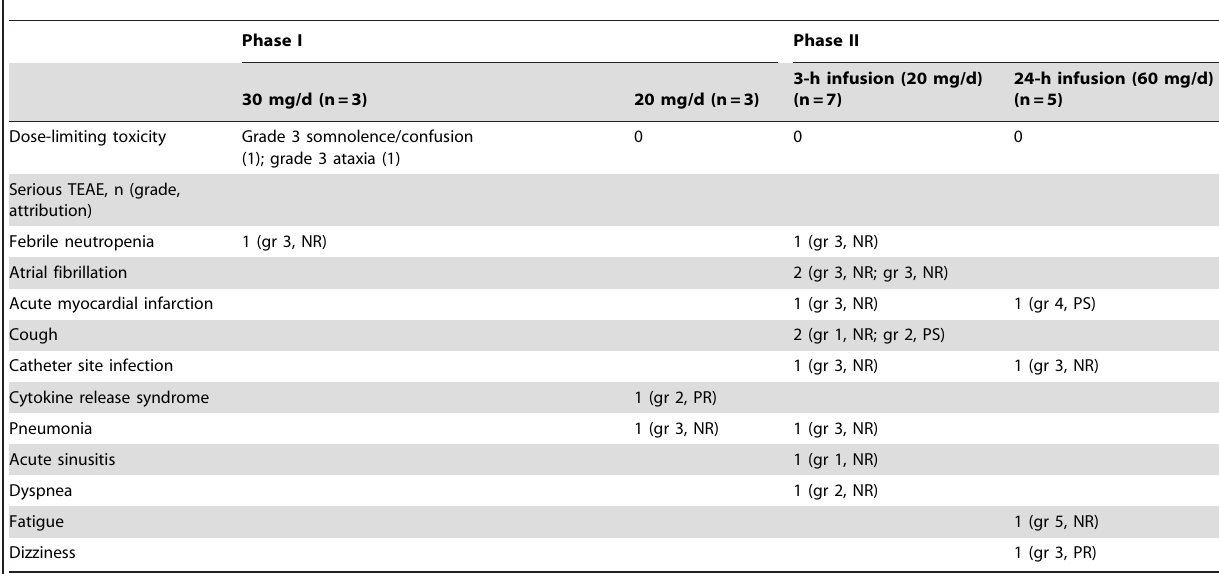
Table 3. Summary of dose-limiting toxicities and serious adverse